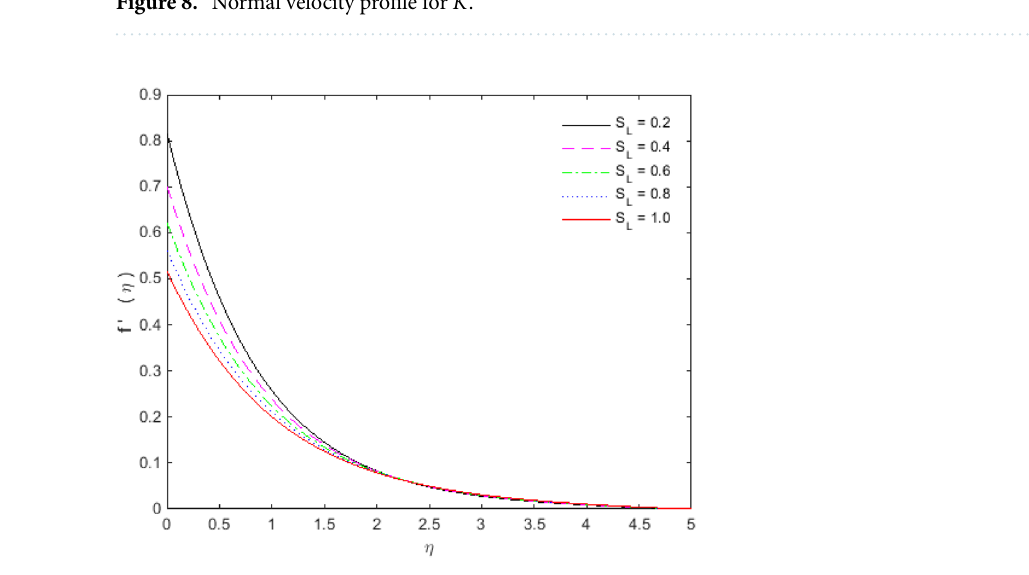
Figure 9. Streamwise velocity profile for S L